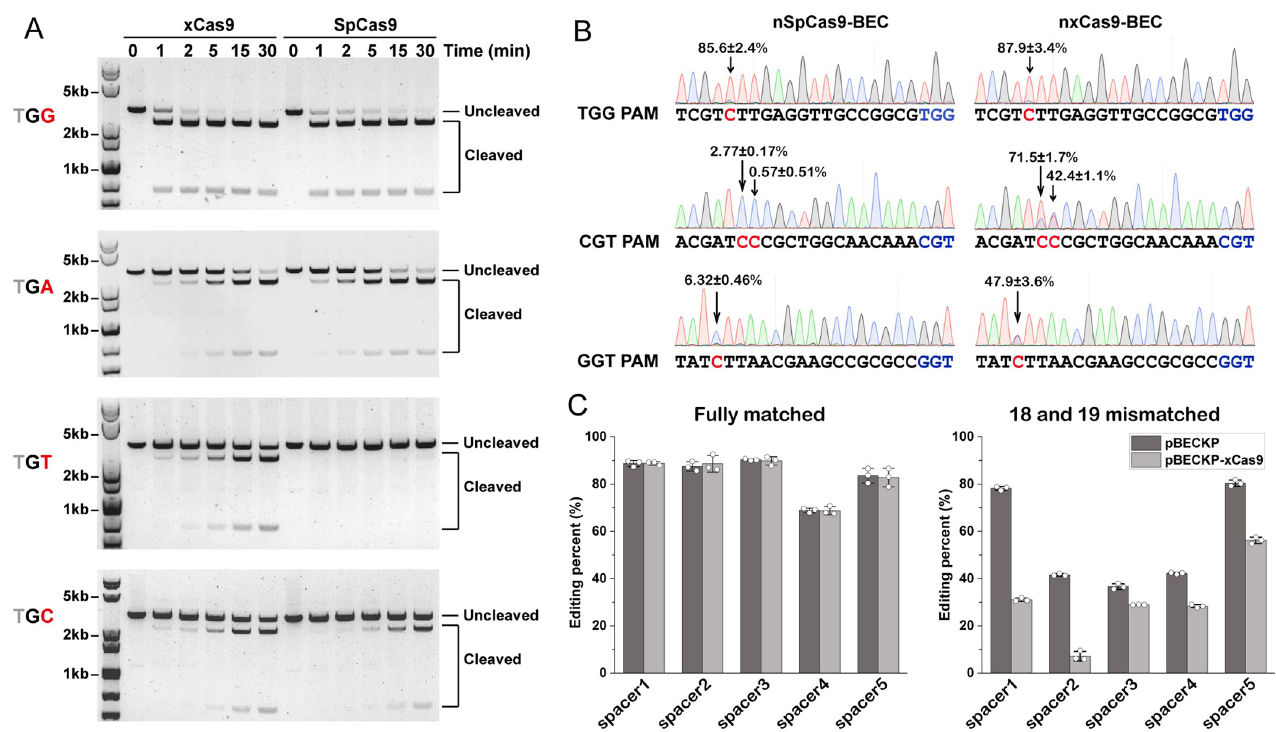
Fig 1. In vitro and vivo activity of xCas9 compared to WT SpCas9. (A) In vitro cleavage assays of xCas9 and WT SpCas9 using linearized plasmids containing a target sequence adjacent to TGG, TGA, TGT, and TGC PAMs. (B) Cytosine base editing efficiency of pBECKP and pBECKP-xCas9 plasmids toward target sequence adjacent to different PAMs in the K . pneumoniae strain KP_1.6366. The experiments were performed in triplicate, and one representative result was shown. The data underlying this figure can be found in S1 Data. (C) Cytosine base editing efficiency of pBECKP and pBECKP-xCas9 plasmids towards five different spacers in the K . pneumoniae strain KP_1.6366. Left panel: fully matched spacer; right panel: 18 and 19 mismatched spacer. The data underlying this figure can be found in S1 Data. PAM, protospacer adjacent motif; SpCas9, Streptococcus pyogenes Cas9; WT, wild-type.